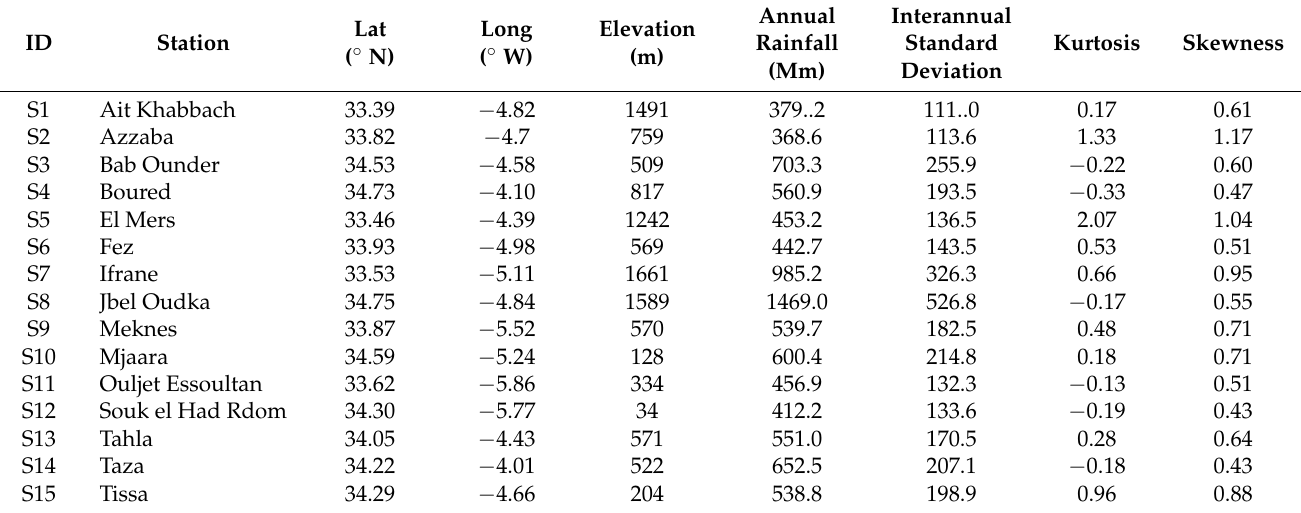
Table 1. Main characteristics of the rain gauge stations used in this